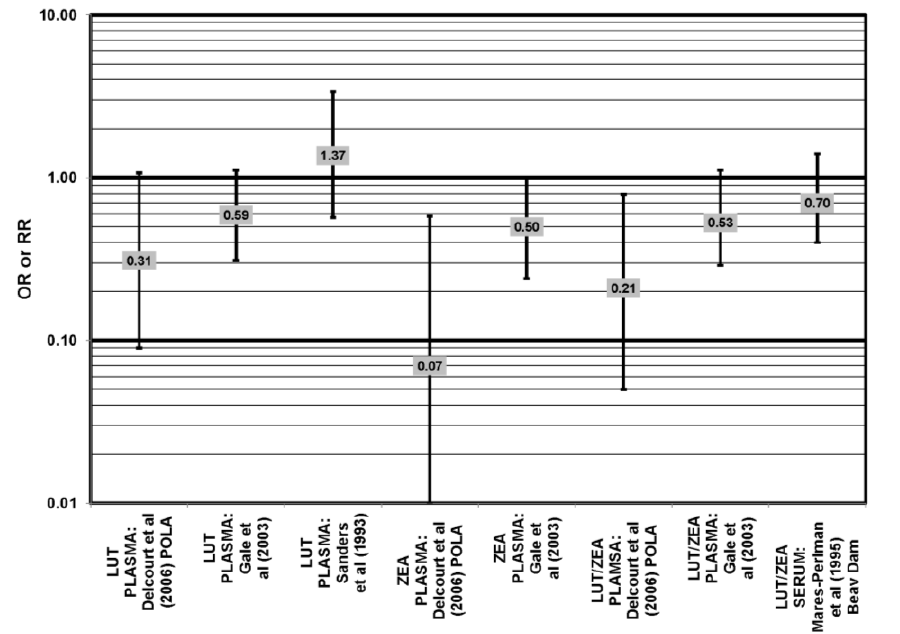
Figure 24. AMD odds or risk ratio; high vs. low blood levels of lutein and/or zeaxanthin: retrospective and cross-sectional studies.